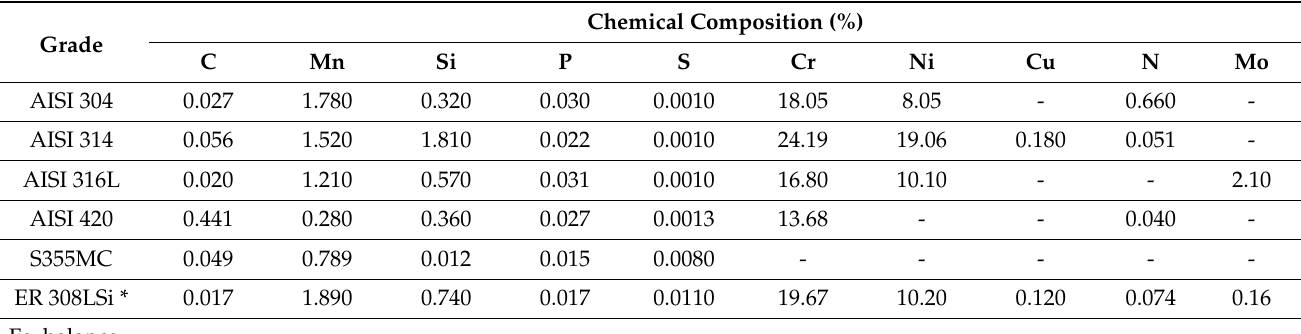
Table 1. Chemical composition of welded sheets.